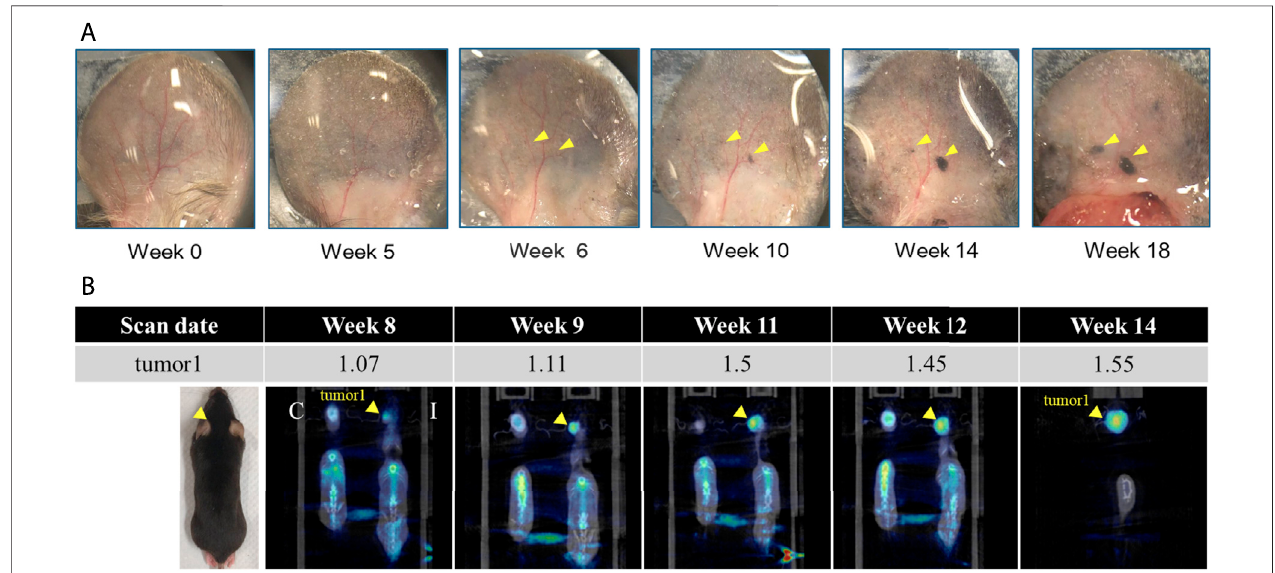
FIGURE 2 | Dysplastic nevi mouse-ear (A) appearance photography and (B) microPET imaging. C: control (left), I: 4-OHT induced (right). Standardized uptake values (SUV) mean in ear of 4-OHT induced mouse, indicated by yellow arrow, was summarized in the table.